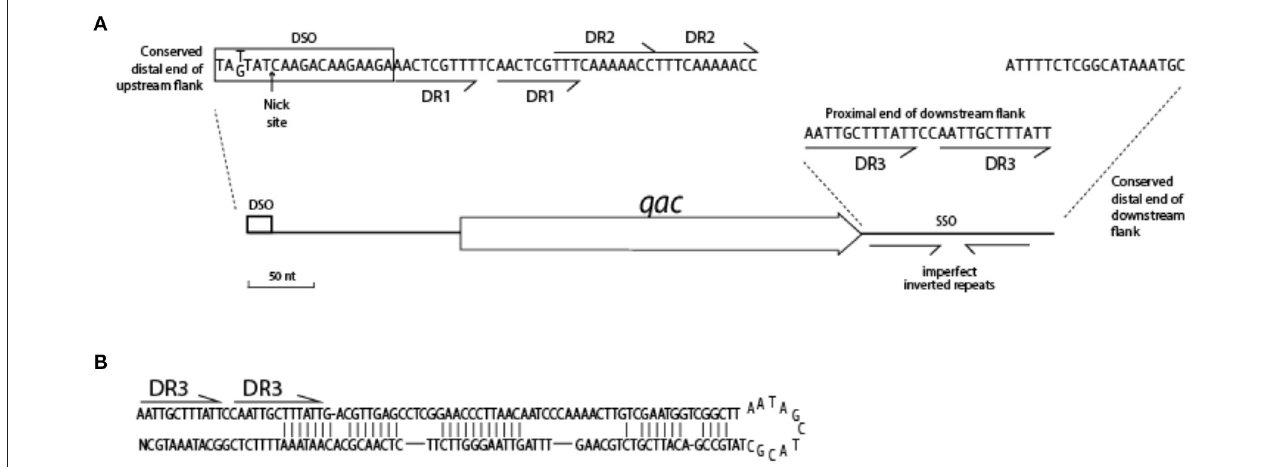
FIGURE 6 | Conserved features of the Qac locus. (A) Sequences indicated are highly conserved in the flanks of 25 qacC, qacG , and qacJ genes. (B) Hairpin structure of SSO for QacC